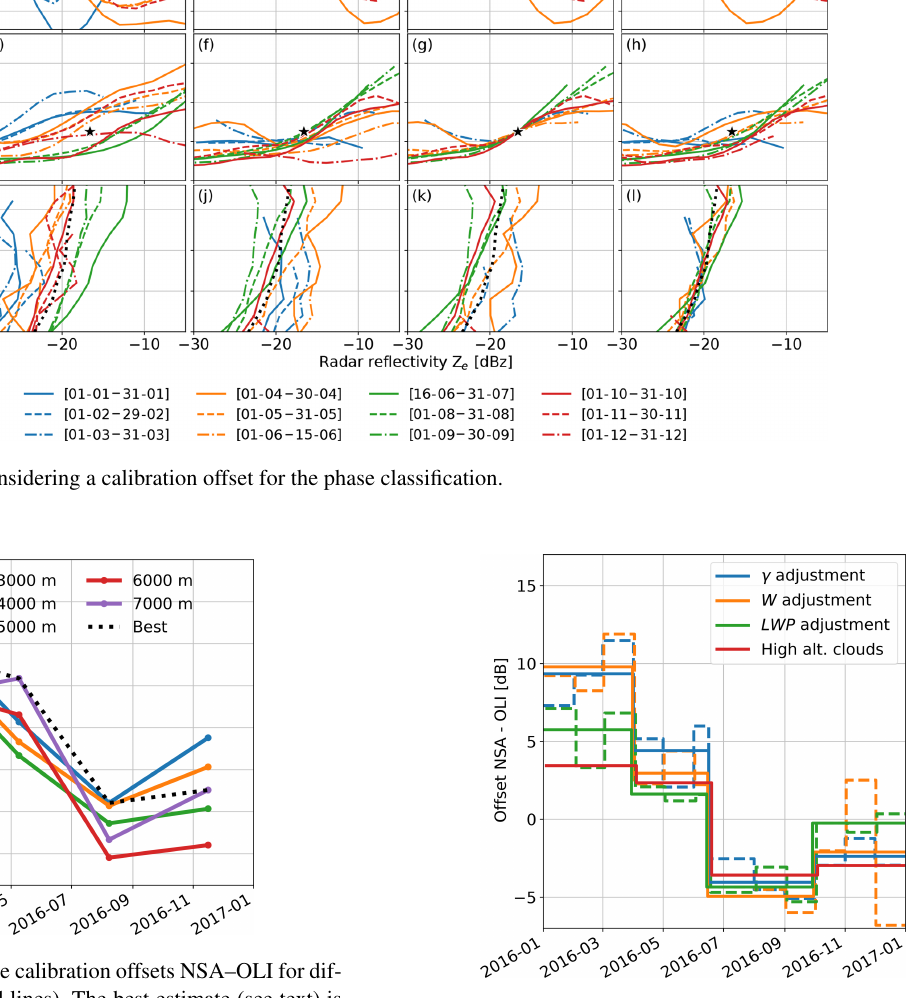
Figure 10. Comparison of relative calibrations NSA–OLI using γ ( O γ = 0 , blue line), W ( O W = 0 . 25 , orange line), and the high-altitude method (green line). All methods have been averaged to the same temporal resolution; the original resolutions are indicated by the dashed lines. For clarity, the lines have been slightly shifted along the x